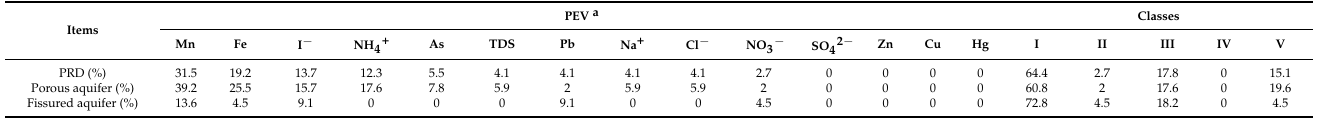
Figure 2. Spatial distribution of groundwater quality in agricultural areas in the Pearl River Delta. Table 1. Groundwater quality and proportions of groundwater samples with concentrations of one indicator exceeding the allowable value (PEVs) of indicators in agricultural lands in the Pearl River Delta.